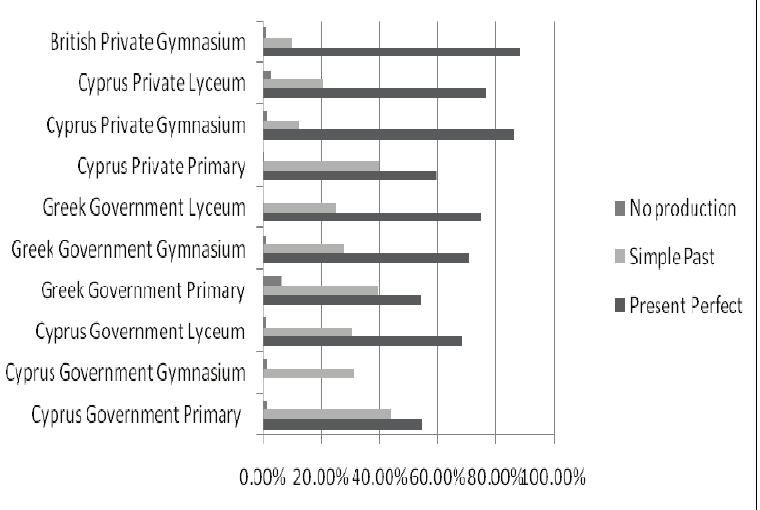
Figure 3: Test production by all groups